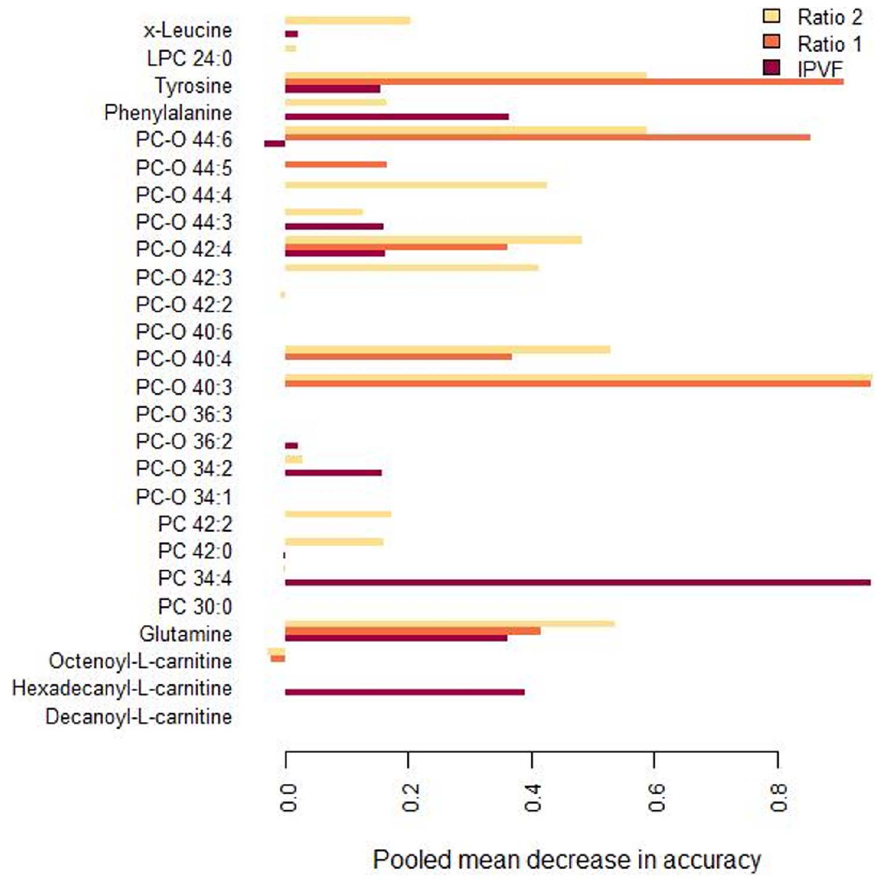
Figure 3. Plot describing metabolite importance and robustness in predicting visceral fat adiposity as assessed by Random forest analysis using metabolic data collected at V0 and V2. Visceral adiposity was associated with increasing concentrations of amino acids (glutamine, leucine/isoleucine, phenylalanine and tyrosine), lysophosphatidylcholine LPC 24:0 and diacyl phospholipids (PC 30:0, PC 34:4). In addition, visceral adiposity was marked by a depletion in ether lipid species PC -O 36:3, PC -O 40:3, PC -O 40:4, PC -O 40:6, PC -O 42:2, PC -O 42:3, PC -O 42:4, PC -O 44:3, PC -O 44:4, PC -O 44:6, and two diacyl phosphocholines (PC 42:0 and PC 42:2). To reflect the weight of the selected biomarkers in the classification of visceral adiposity, a pooled mean decrease of accuracy for each compound was calculated from 10000 forest generations. Higher variable importance corresponds to higher values of pooled mean decrease in accuracy. Key: IPVF, intraperitoneal fat volume; LPC, Lysophosphatidylcholines; PC, Phosphatidylcholines; PC-O, 1-O-alkyl-2- acylglycerophosphocholines; Ratio1, intraperitoneal/subcutaneous fat ratio; Ratio 2, intraperitoneal/ abdominal fat ratio. Assignment of PC-O species is made on the assumption that only even numbered carbon chains are present. A potential overlap between PC species containing odd-chain fatty acids and even-chained PC-O species cannot be excluded with low mass